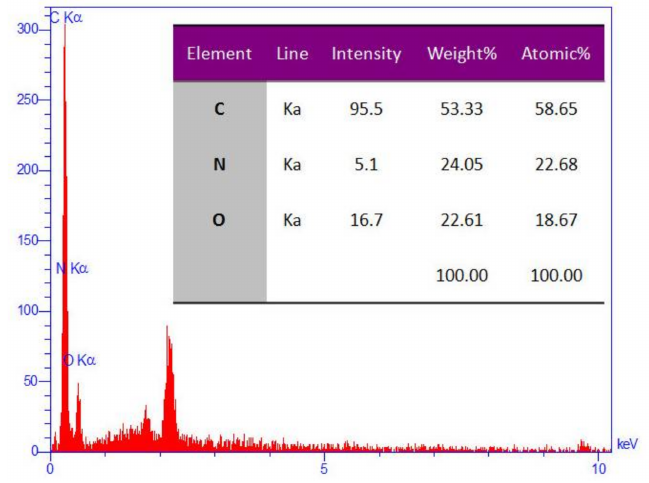
Figure 4. The EDS (Energy-dispersive X-ray spectroscopy) analysis of GO/PAMAM. The nitrogen-based BET specific surface area of GO/PAMAM was achieved by a Micrometrics-Tristar 3020 equipment (Micrometrics, Narcross, GA, USA), Figure S1. The resulted isotherm is type IV. These isotherms are the characteristic of porous materials and nitrogen molecules were condensed in the tiny capillary mesopores of adsorbent. The BET surface area, t-plot micropore area, adsorption average pore diameter (by BET), and pore volume for GO/PAMAM were 3.26 m 2 · g − 1 , 1.19 m 2 · g − 1 , 18.0 nm, and 0.015 cm 3 · g − 1 , respectively. The hysteresis loop of BET isotherm was H3, which was originated from aggregates (loose assemblages) of platelike particles (here GO sheets